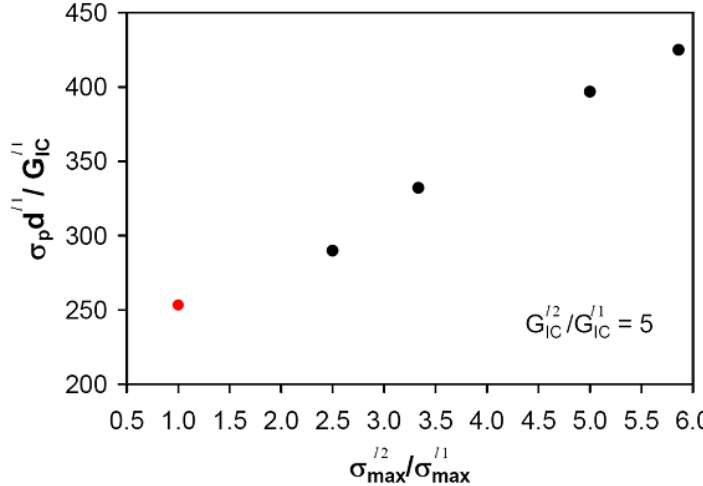
Figure 9: dimensionless tensile strength vs. CZM peak stress ratio between levels 2 and